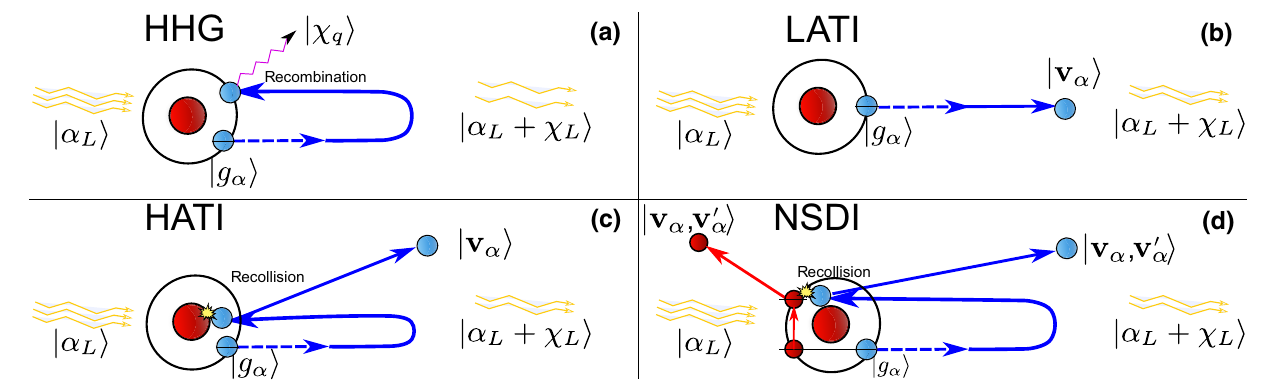
FIG. 1. Depiction of the key quasiclassical strong-field processes, along with the quantum states of light and matter. (a) High-harmonic generation (HHG), (b) low-order above-threshold ionization (LATI) without rescattering events, (c) high-order above- threshold ionization (HATI) including rescattering events, (d) nonsequential double ionization (NSDI). The states of the driving field mode before and after interaction are given by | α L (cid:2) and | α L + χ L (cid:2) , respectively. High-order harmonic modes, due to HHG, are given